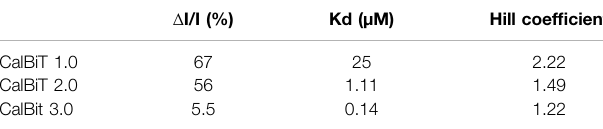
TABLE 2 | Properties of three versions of CalBiT reported here. Δ I/I (%) Kd ( μ M) Hill coef fi cient CalBiT 1.0